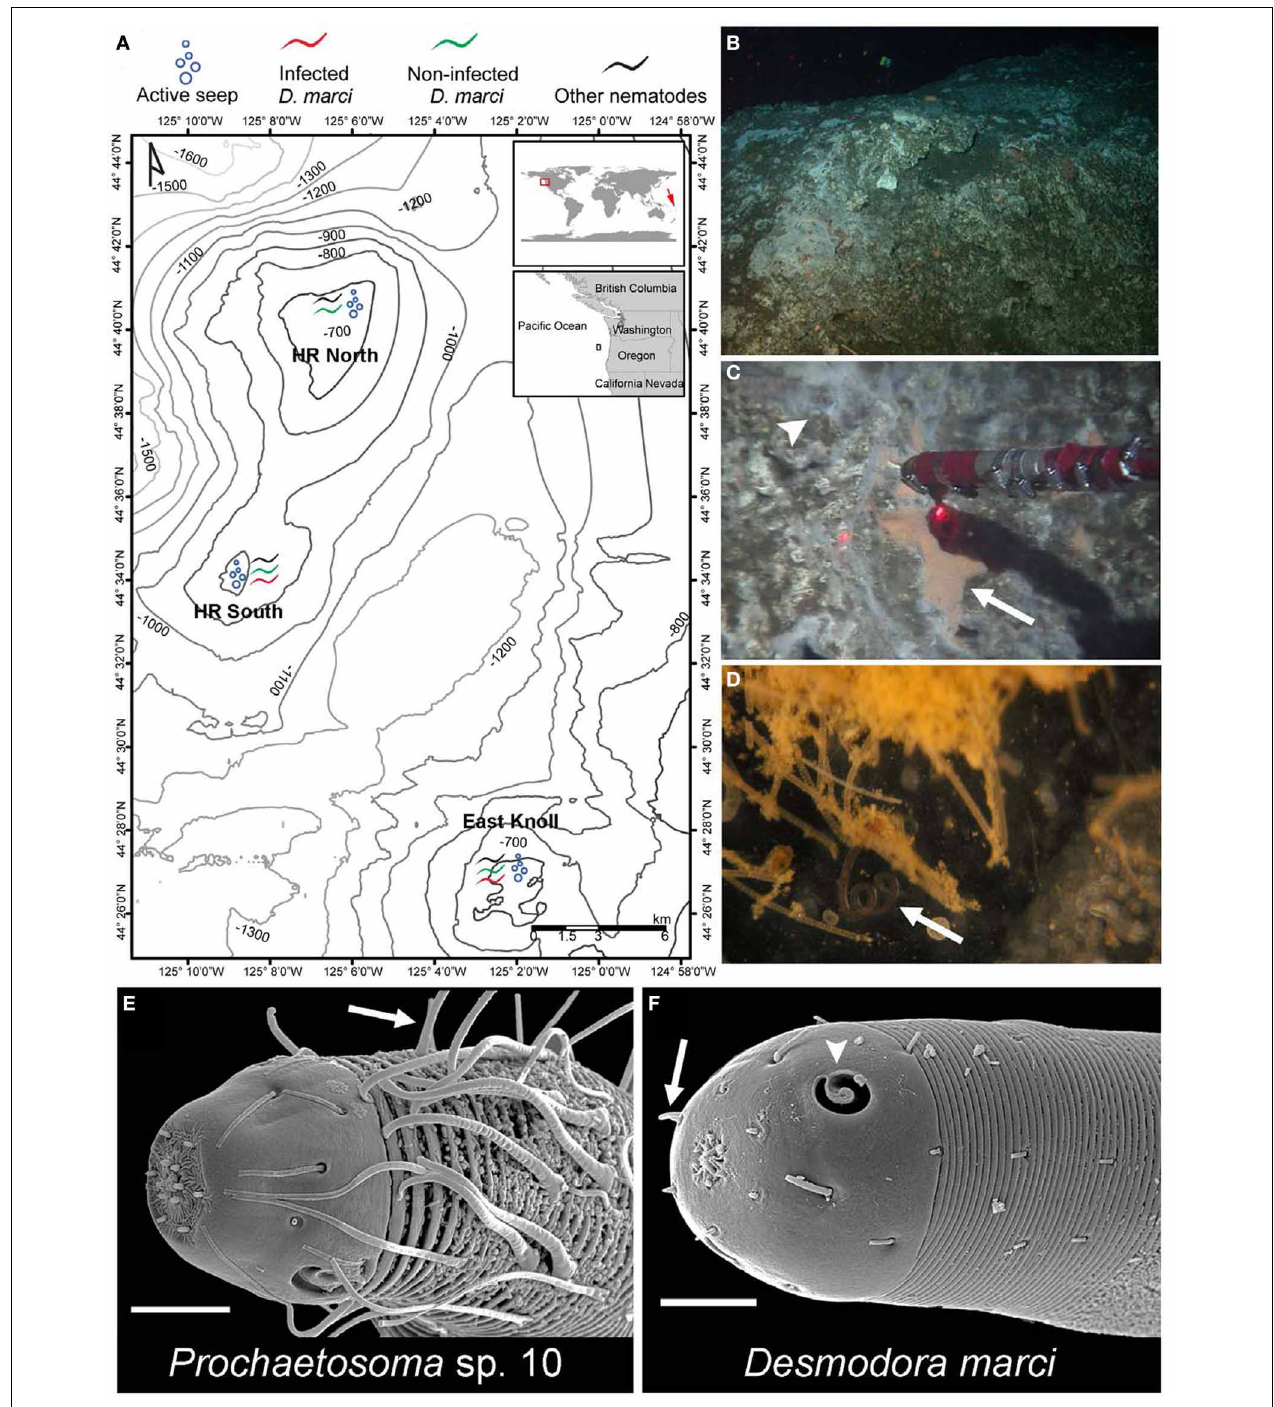
FIGURE 1 | Hydrate Ridge methane seeps are inhabited by Desmodora and Prochaetosoma nematodes. (A) A map of Hydrate Ridge with the 2010 and 2011 sampling sites and location where infected and non-infected D. marci worms were found. On the global map, a red square marks HR where we found infected D. marci nematodes. A red arrow marks the location of the Lau Basin hydrothermal vent systems where D. marci was previously reported (Verschelde et al., 1998). (B) In situ photo of a typical HR carbonate rock. (C) Orange bacterial mat (arrow) on a carbonate rock within an active